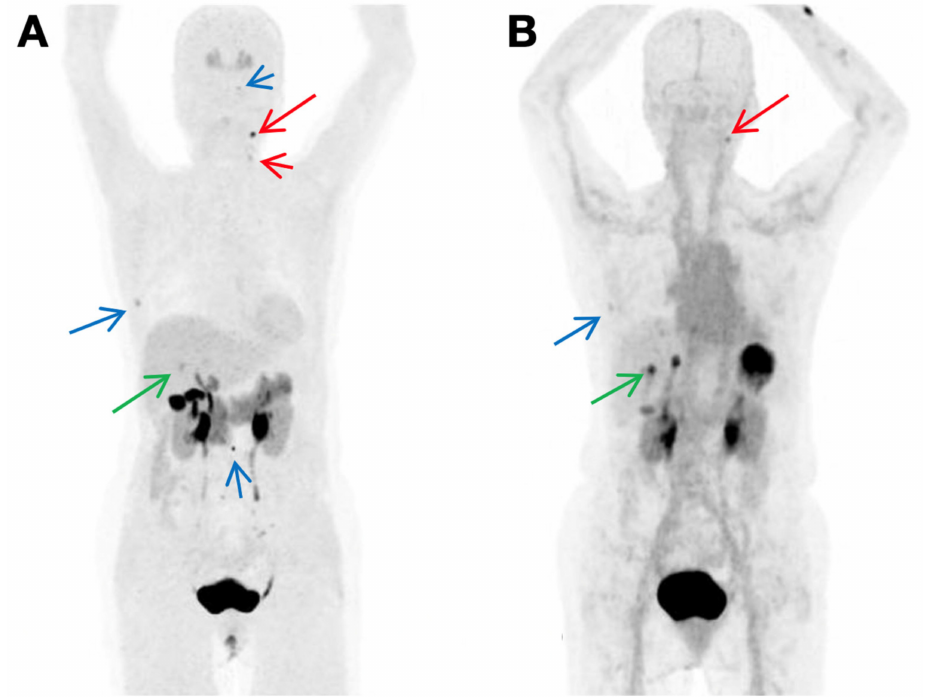
Figure 7. Comparison of [ 18 F]FDOPA and [ 68 Ga]Ga-DOTA-MGS5 in MTC patients. ( A ) [ 18 F]FDOPA PET imaging at one hour post-injection. ( B ) 68 Ga-Ga-DOTA-MGS5 PET imaging at one-hour post-injection. [ 68 Ga]Ga-DOTA-MGS5 yields complementary information to [ 18 F]FDOPA-PET. Reproduced with permission from [96], copyright 2021, Springer Nature